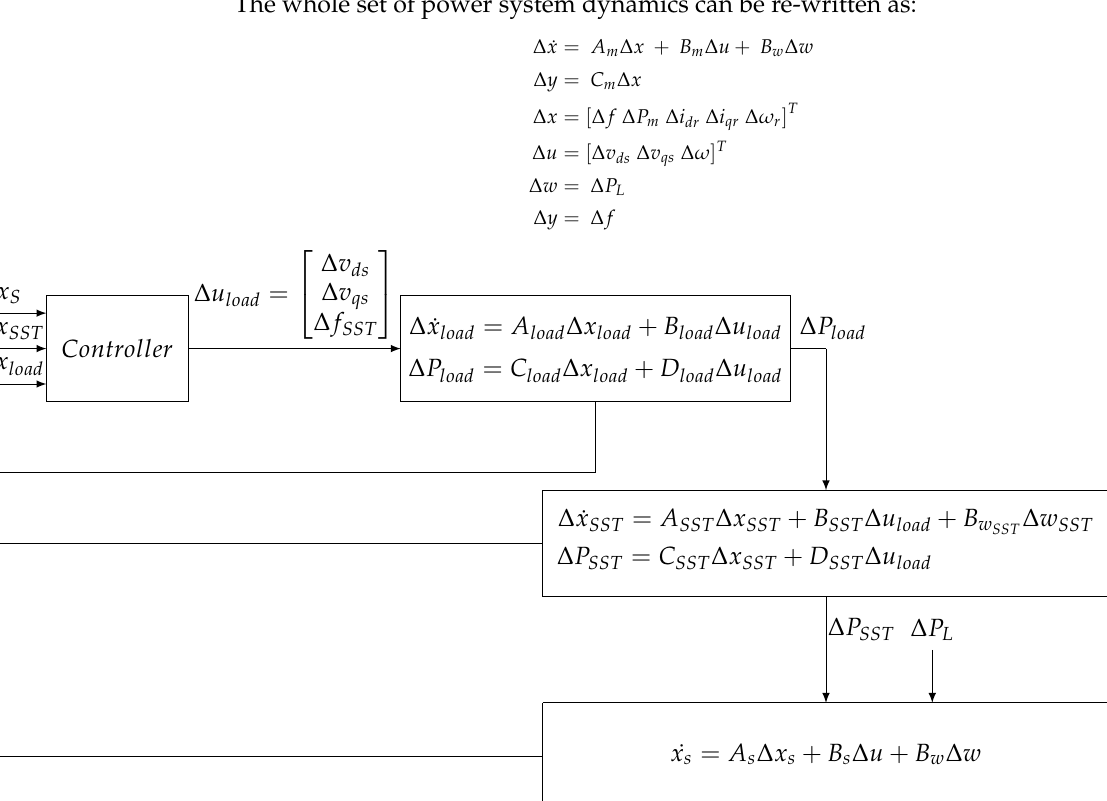
Figure 5. Block diagram conceptualization of power system dynamics, including load, SST, and frequency dynamics in